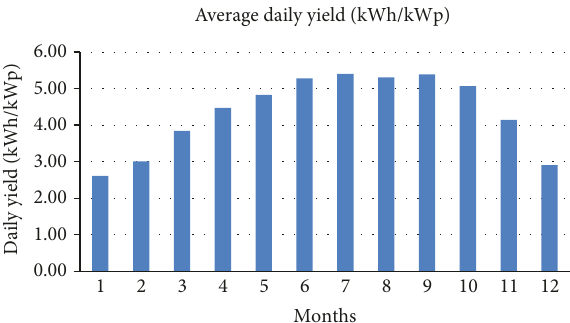
Figure 7: Average daily yield (kWh/kWp).